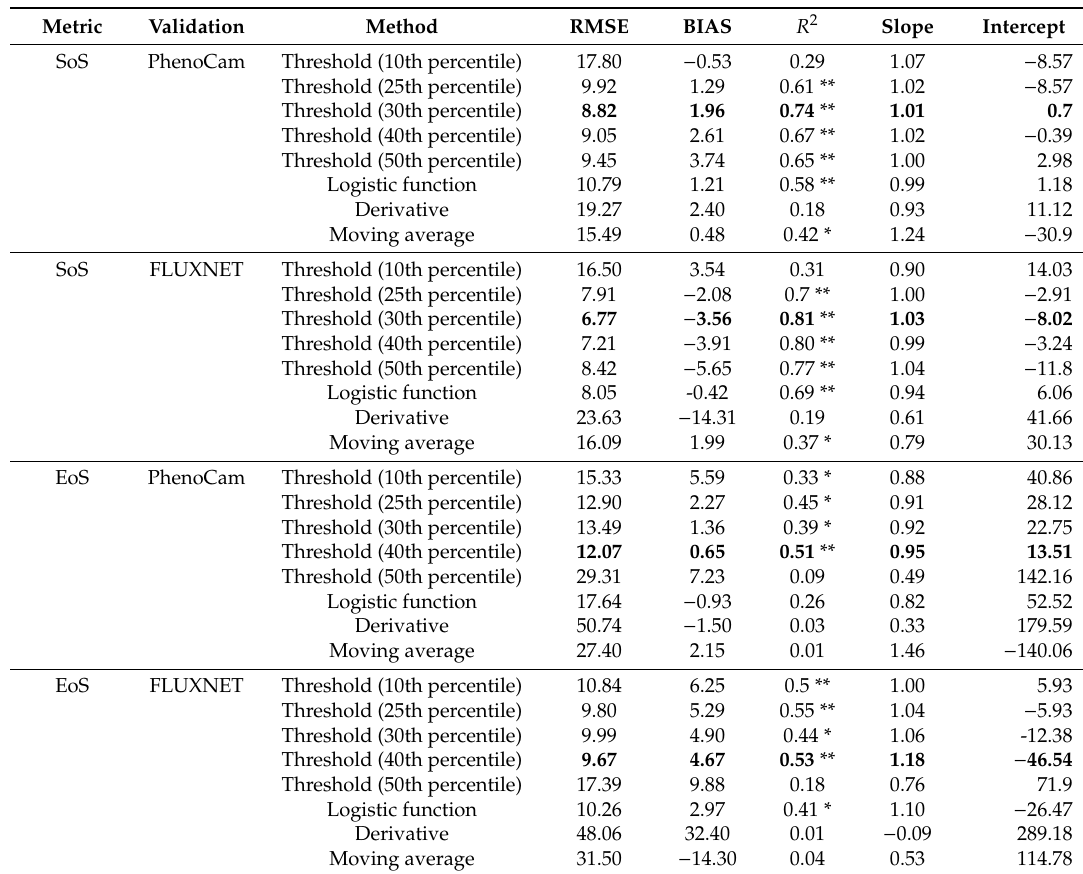
Table 2. Statistics of the comparison between the SOS and EOS dates retrieved using the LAI, GCC, and GPP estimates for the four methods: thresholds, logistic function, derivative and moving average. * indicates significant correlations at p < 0.05; **, significant correlations at p < 0.001. The bold type highlights the best method. Evaluation over the 64 PhenoCam sites (356 samples (sites × years)) and 16 FLUXNET towers (110 samples (sites × years)) over deciduous forests in the North Hemisphere (Figure